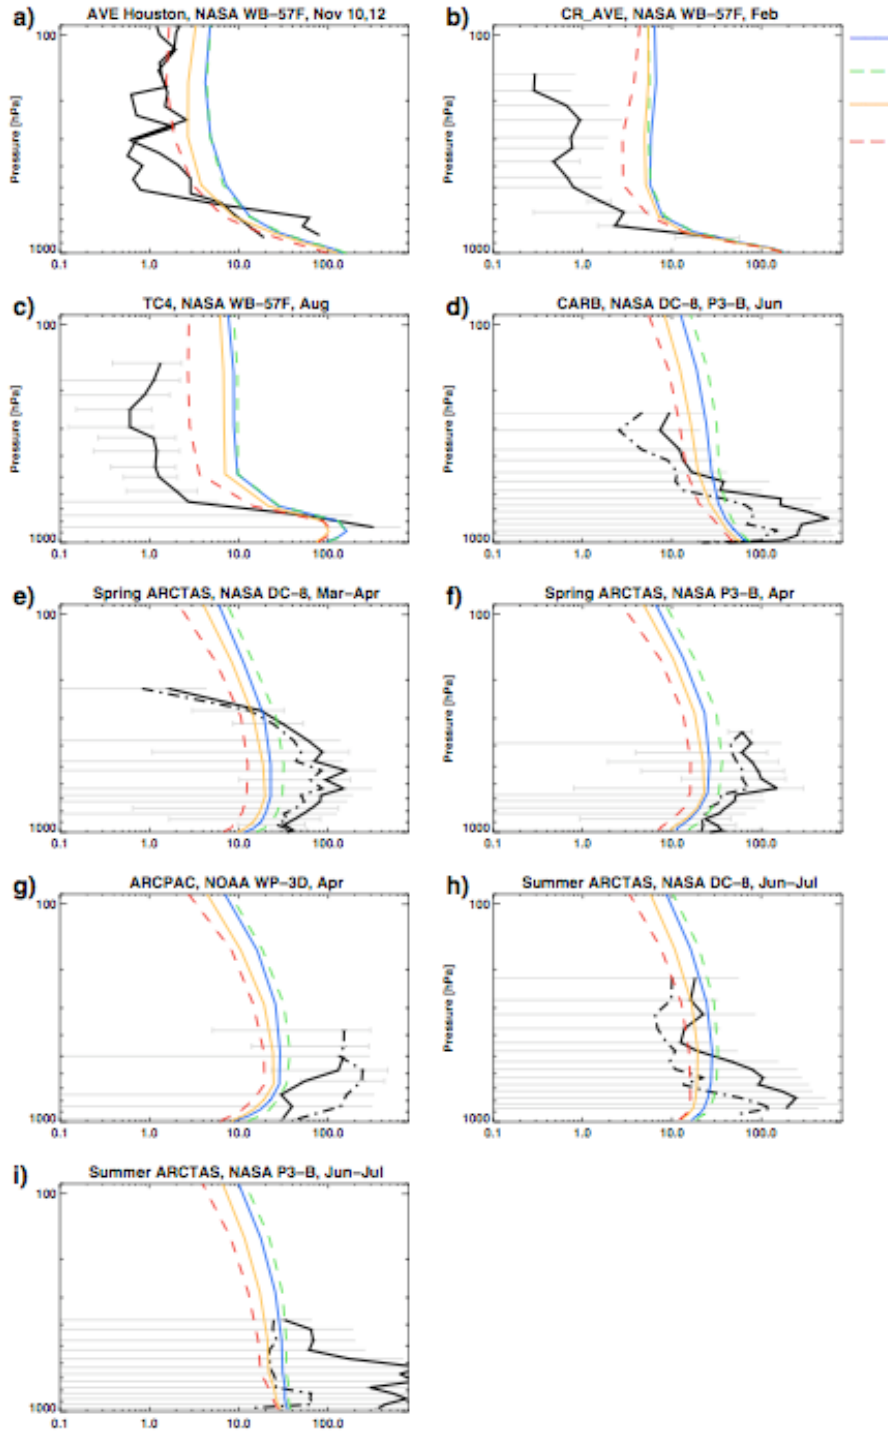
Figure 5 Modeled (colored) and observed (black lines) BC mass profiles in [ng/kg] in the tropics and mid-latitudes (a–d) and ARCPAC and ARCTAS campaign (e–i). Observations are averaged for the respective campaigns, with standard deviations where available. The two black lines in (a) show measurements on two different days. All other profiles give multiple day averages. Mean (solid) and median (dashed) observed profiles are provided except that (g) the ARCPAC campaign has distinct profiles for the mean of the 4 flights that probed long-range biomass burning plumes (dashed) and mean for the flight that sampled aged Arctic air (solid).